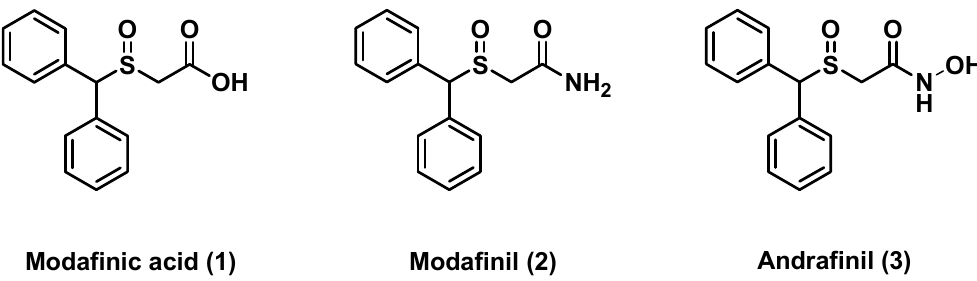
Figure 1. Structures of modafinic acid ( 1 ), modafinil ( 2 ) and andrafinil ( 3